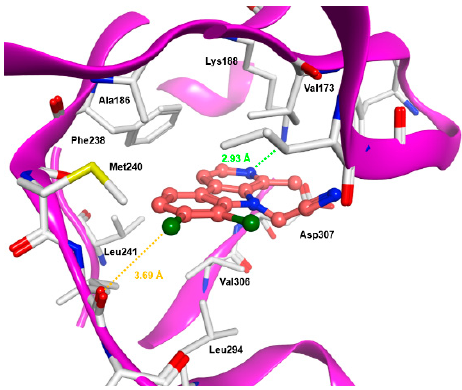
Figure 6. Harmine-bauerine C hybrid AnnH69 docked into DYRK1A (PDB 4YU2). Carbon atoms in light brown, chlorine atoms in green, nitrogen atoms in blue, oxygen atoms in red.